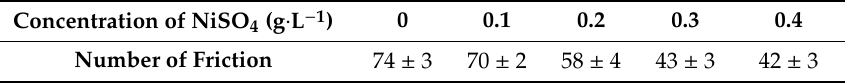
Table 5. Friction numbers for the different colored specimens recorded before breakdown.